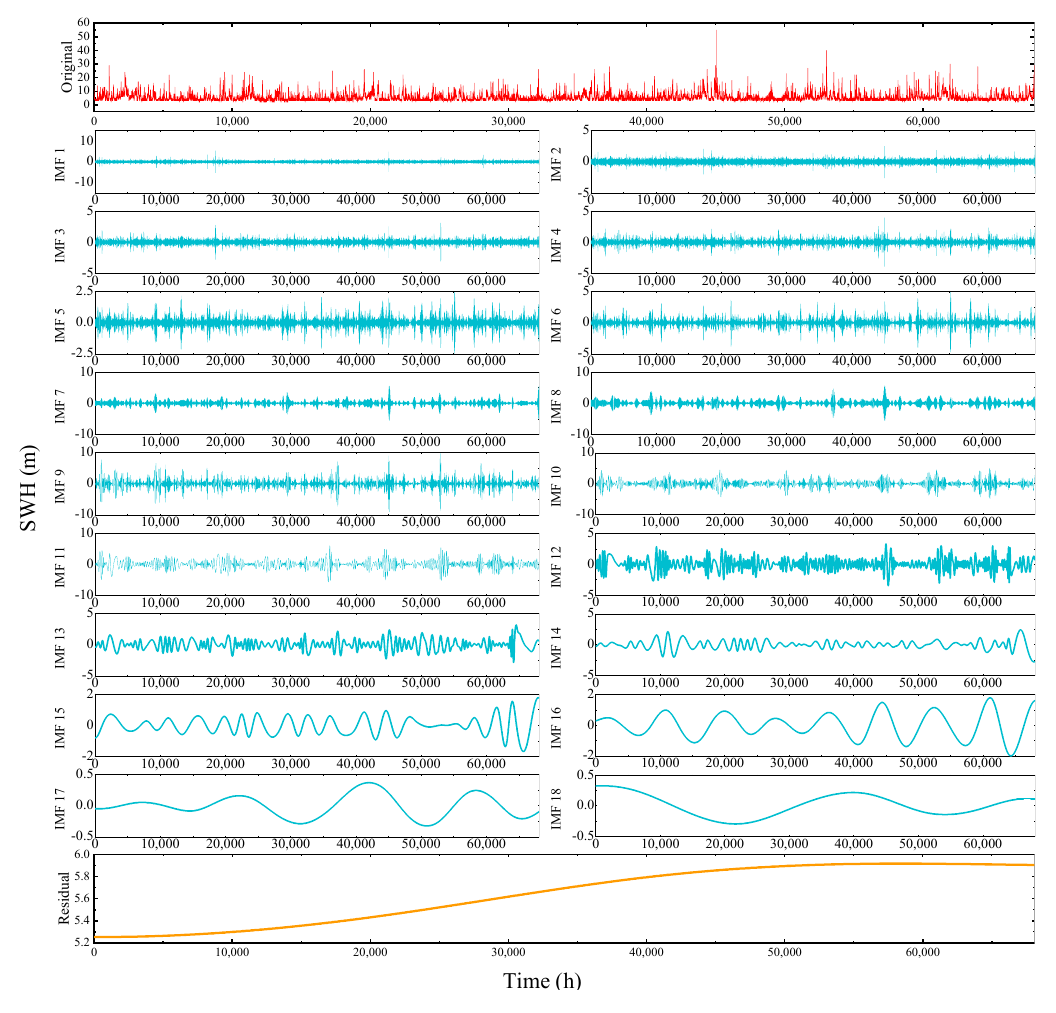
Figure 8. Comparison of ShiDao effective data in the time domain for the IMFs component of SWH sequence by EMD